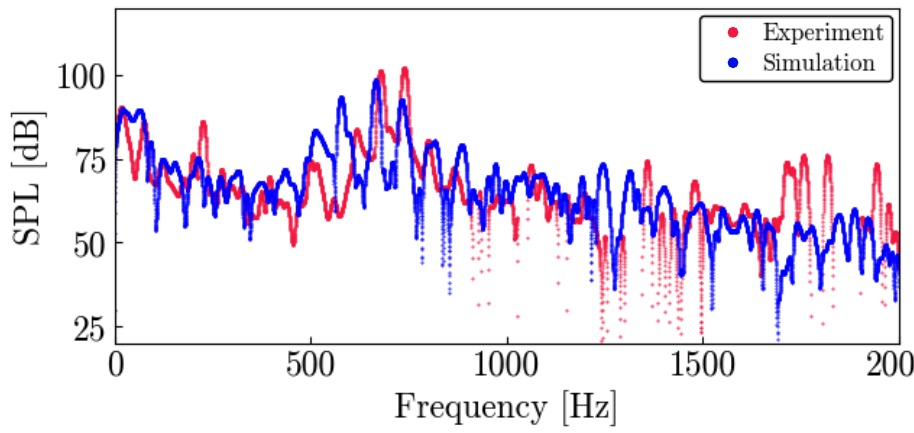
Figure 11. Sound pressure level probed at x = 200 mm (corresponding to 80% chord position) on the pressure side